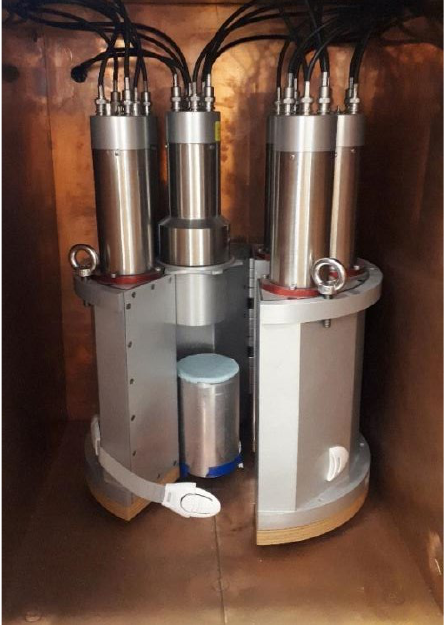
Figure 3. Unique gamma spectrometry system with an active anticoincidence shield.